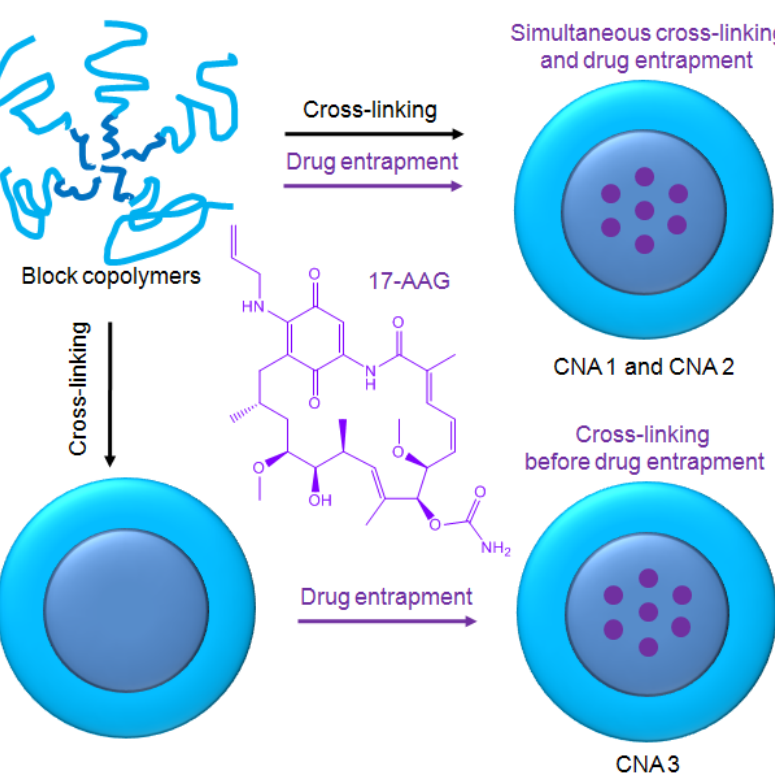
Figure 1. Preparation of CNAs entrapping